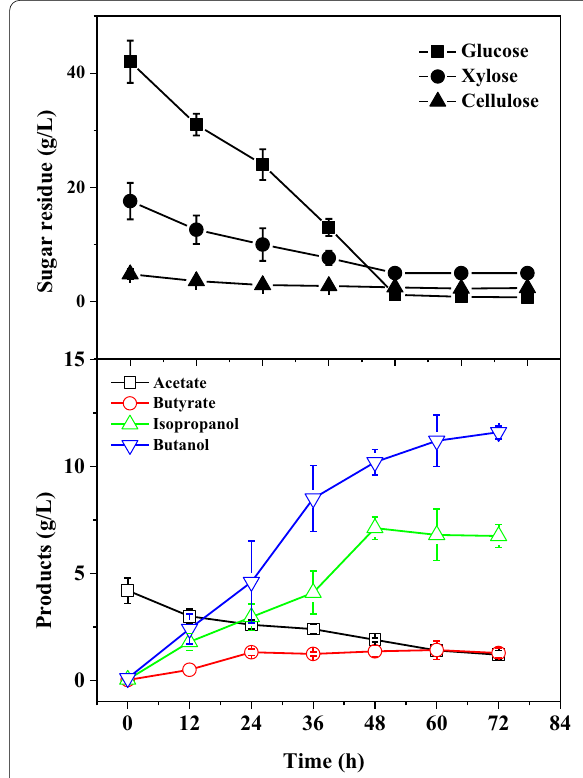
Fig. 5 BI fermentation by Clostridium beijerinckii XH29 in P2 medium supplemented with DTH